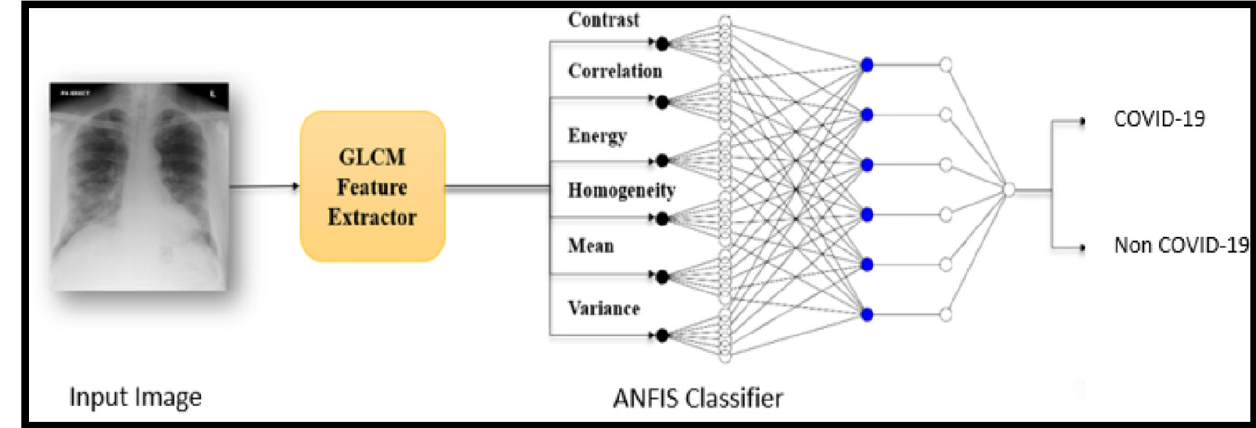
Figure 2. Combination of two technologies, i.e., Fuzzy and Neural.